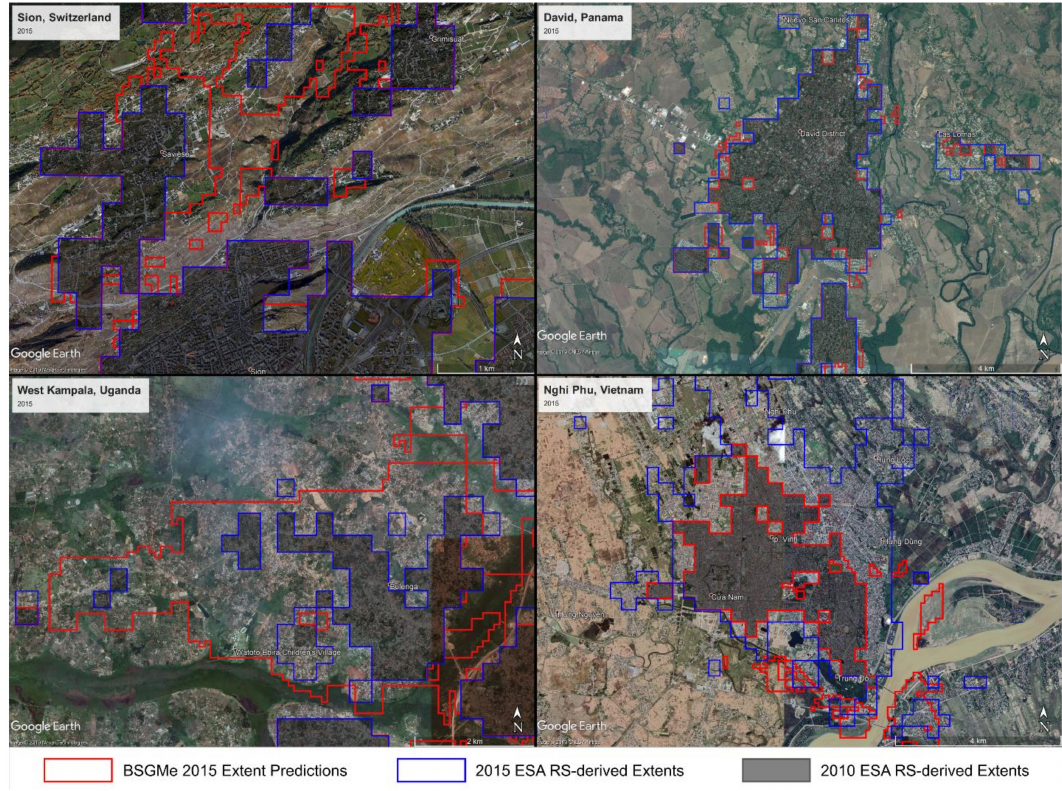
Figure 7. The 2015 BSGMe-derived extents (red), the 2015 ESA RS-derived extents (blue), and the 2010 ESA RS-derived extents (transparent black areas) of BS overlain on 2015 true color imagery via Google Earth. Map Imagery: Google, Maxar Technologies, Centre National D’ Etudes Spatiales CNES /